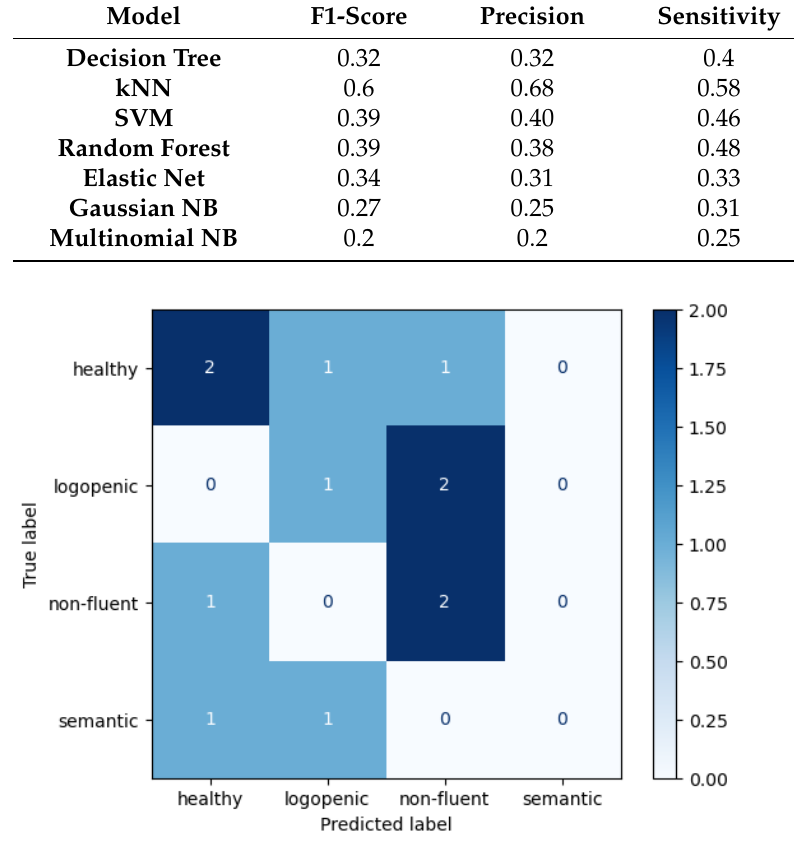
Figure 9. Confusion matrix from kNN multiclass classification